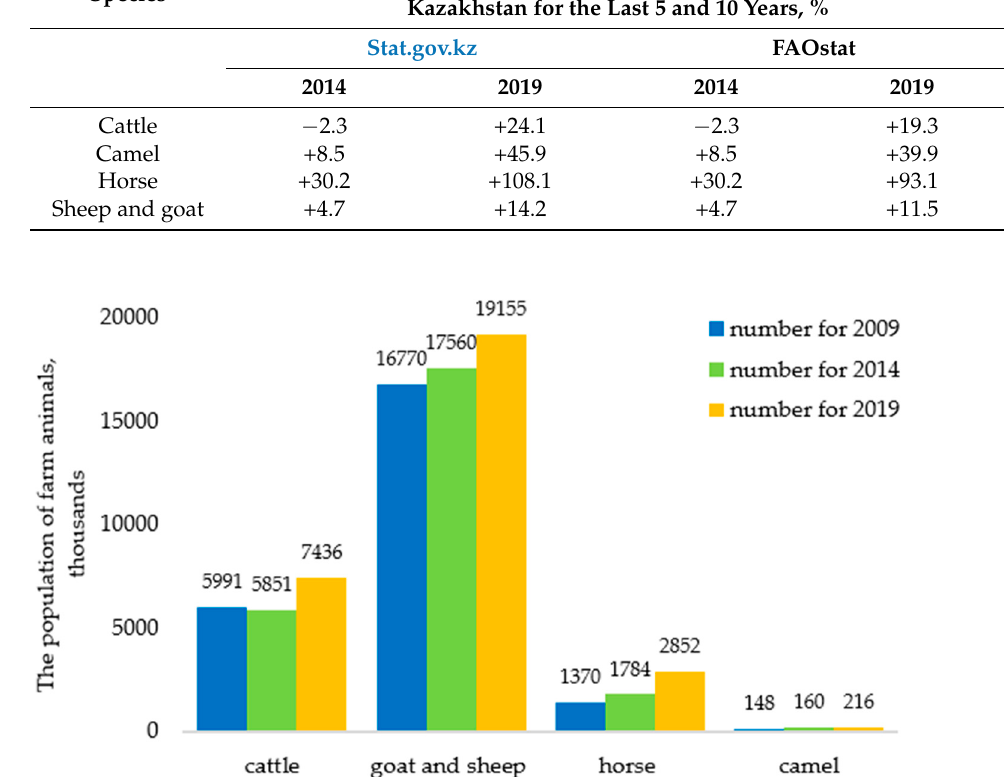
Table 5. Livestock population growth between 2009 and 2019 (index 100 in 2009) (source: FAOstat, 2021. Available online: www.fao.org (accessed on 26 May 2021)).